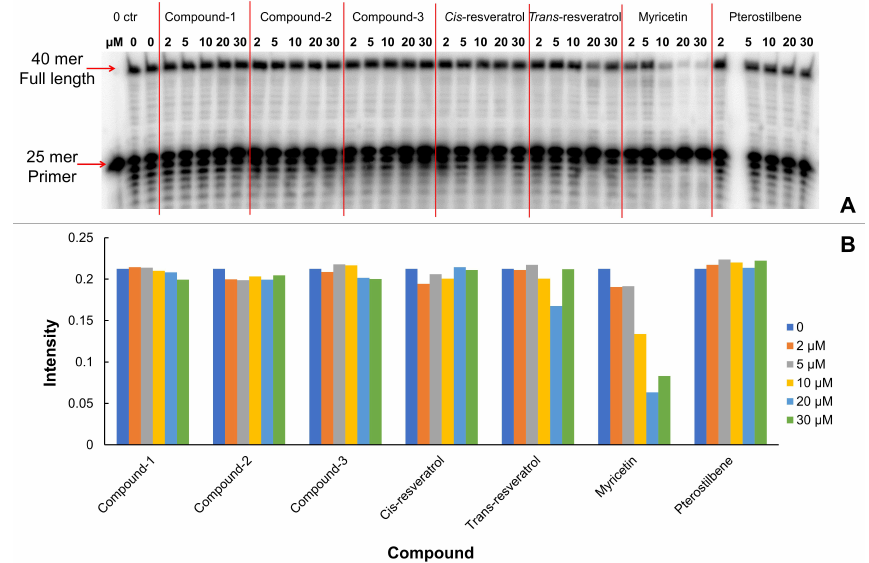
Figure 4. ( A ): Effects of increasing concentrations of resveratrol and its selected analogs on DNA oligo extension by human DNA polymerase δ . The first lane is the 25 mer primer, and the second and third lanes are the controls of the polymerase δ extension assay without addition of analogs. The inhibitors tested were compound-1, compound-2, compound-3, cis -resveratrol, trans -resveratrol, myricetin, and pterostilbene. The concentrations tested for each inhibitor were 2, 5, 10, 20, and 30 µ M; ( B ) Bar chart of intensity of the full-length 40 mer products (as shown in A ) by increasing concentrations of resveratrol and its selected analogs. Table 1. The MM-GBSA energies of the ligands bound to DNA polymerase α (PDB ID: 4Q5V) and HIV-1 reverse transcriptase (PDB ID: 5TXM).